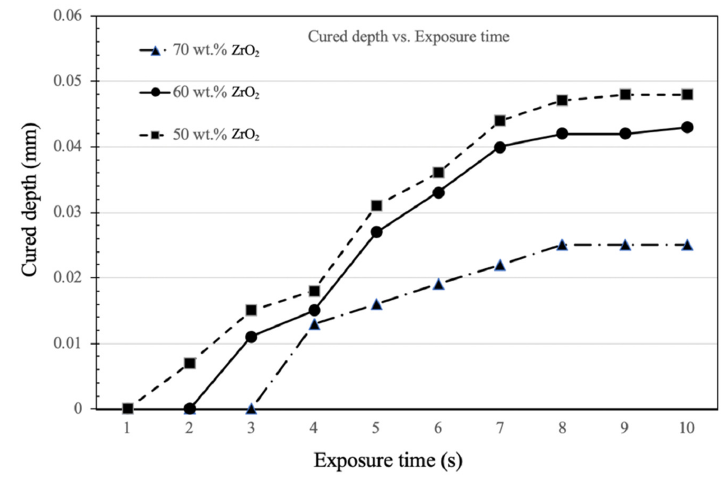
Figure 8. Curing depth curve for various exposure times (seconds).